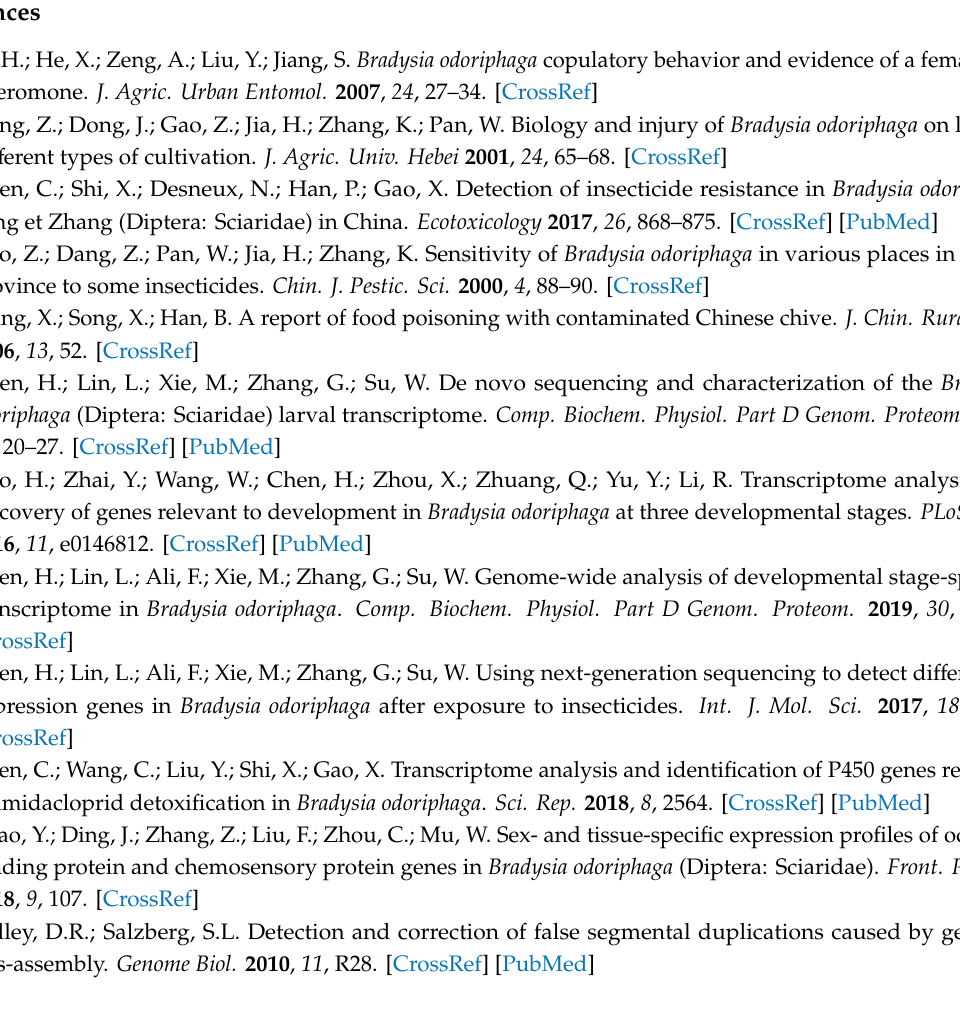
Table S1: Values of samples detected by Agilent 2100, Figure S1: Sequences of AChE1 and AChE2 in B. odoriphaga